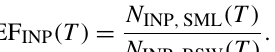
ing SML and BSW samples